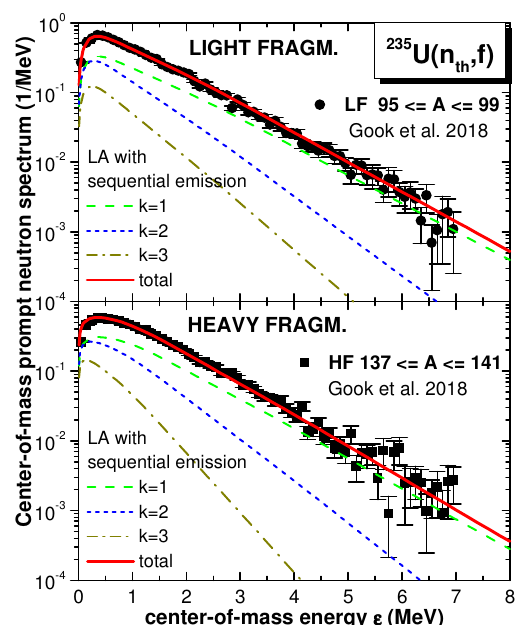
Fig.3 : Prompt neutron spectra in the centre-of-mass frame corresponding to the light and heavy fragment group (upper and lower part, respectively): The result of the LA model with sequential emission: Φ k ( ε ) of the first three emitted neutrons (different dashed and dotted lines) and the total Φ ( ε ) (red solid line) describing very well the experimental data of Göök et al.[5] (symbols).